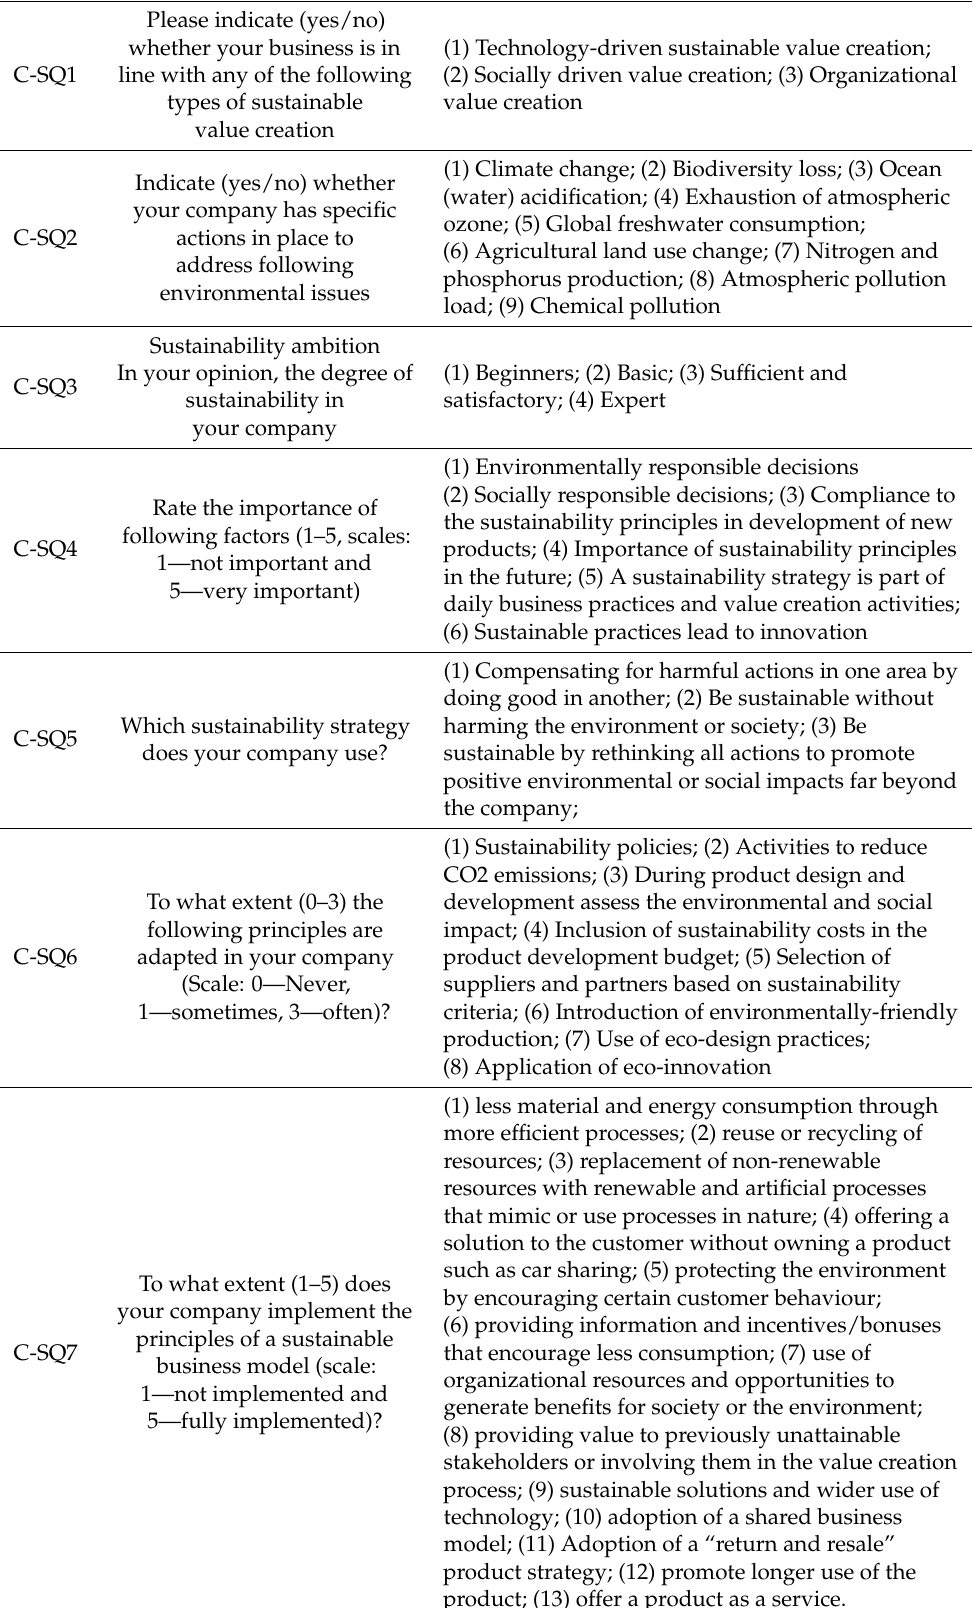
Table A4. The intention to create a positive impact to the planetary boundaries, the sustainability ambition, and the sustainability strategies